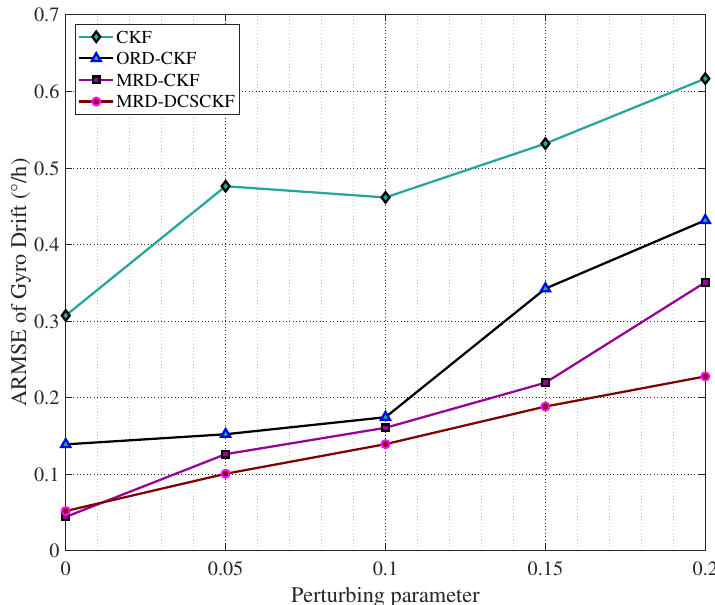
Figure 23. ARMSEs of gyro drift under different perturbing